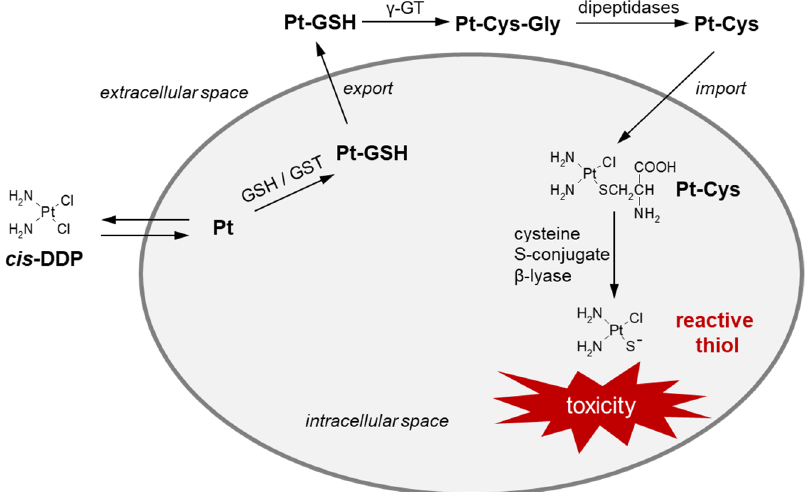
Figure 17. Cisplatin ( cis -DDP) bioactivation through GSH S-conjugate (Pt-GSH) and cysteine S- conjugate (Pt-Cys) formation [18,52]. cis -DDP = cisplatin; GSH = glutathione; GST = glutathione S-transferase; γ -GT = γ -glutamyl transferase; Pt = platinum (II) aqua species.